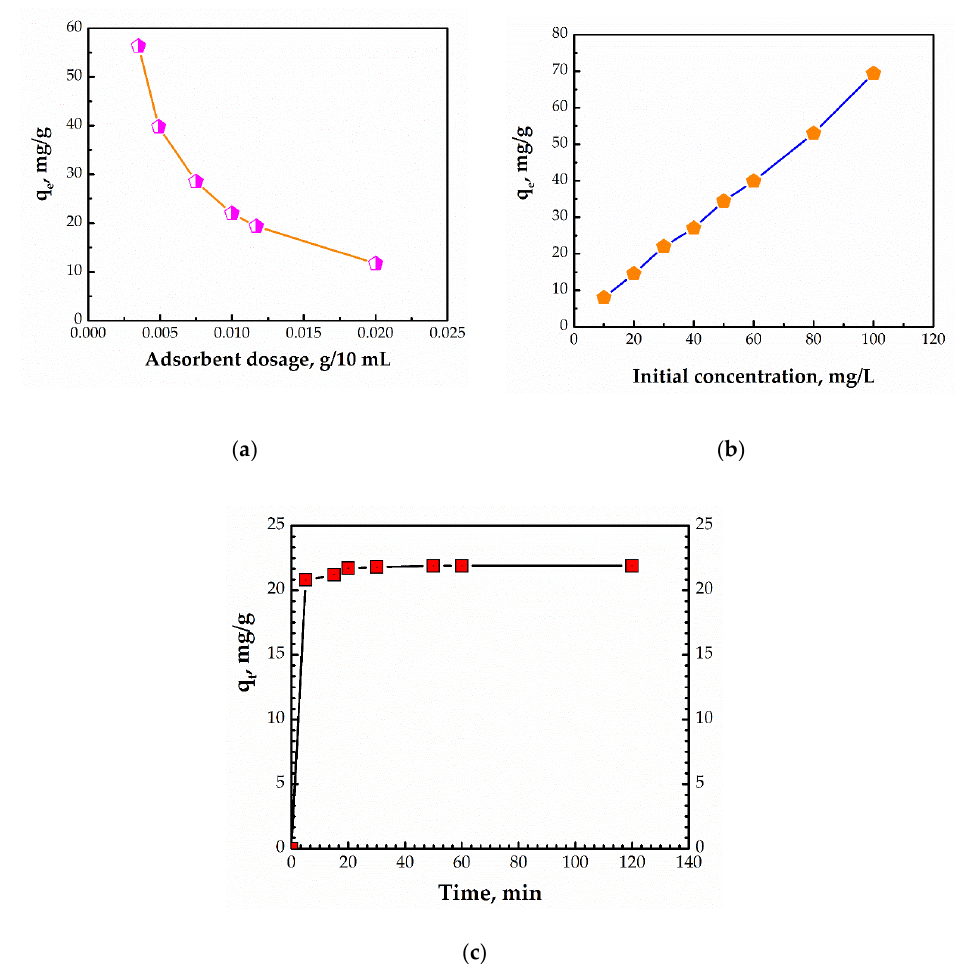
Figure 2. Effect of ( a ) magnetic adsorbent dosage; ( b ) initial Congo red dye concentration; ( c ) contact time.